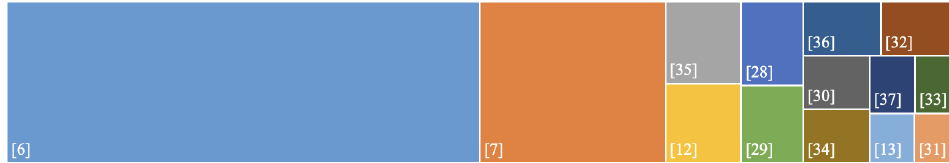
Figure 6. Citation Treemap (References